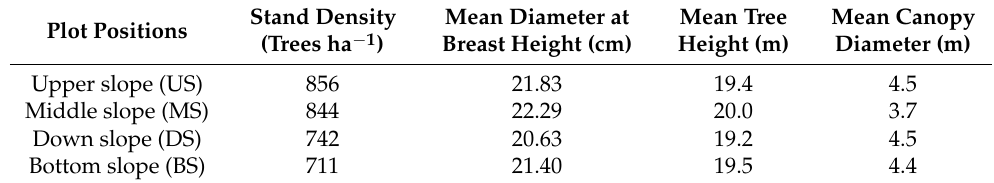
Table 1. The location information of Larix principis - ruprechtii plantation plots on the study slope. Slope Elevation Horizontal Plot Positions Elevation (m) Gradient ( ◦ ) Difference ( ∆ H ) Distance ( ∆ d ) Upper slope (US) 2471 26.3 259 1501 Middle slope (MS) 2397 26.8 333 1339 Down slope (DS) 2293 29.0 437 1092 Bottom slope (BS) 2273 34.9 457 1050